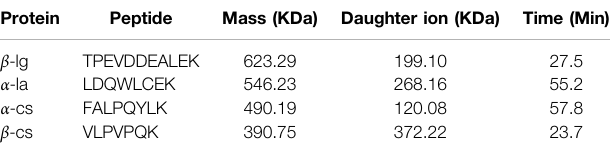
TABLE 2 | Ion information of characteristic peptides.